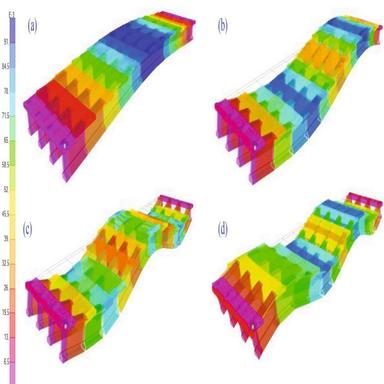
Modal shapes of the bridge deck with 4 beams: (a) first, (b) second, (c) third and fourth flexural vibration mode.